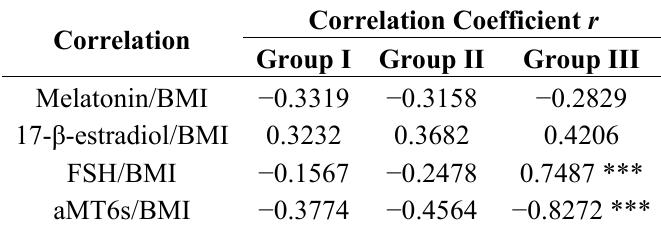
Table 1. Correlation between body mass index (BMI) and melatonin, 17-β-estradiol,